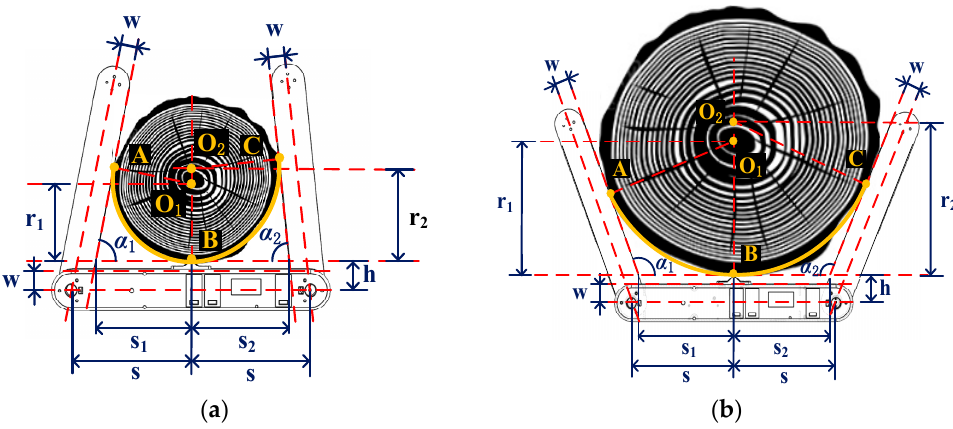
Figure 8. Measurement method of tree DBH: ( a ) for a small tree and ( b ) a large tree. Here, w equals the half width of the arms or beam; h equals w plus the maximum width of the vertex; and s equals the half distance between the axes of two angle sensors.